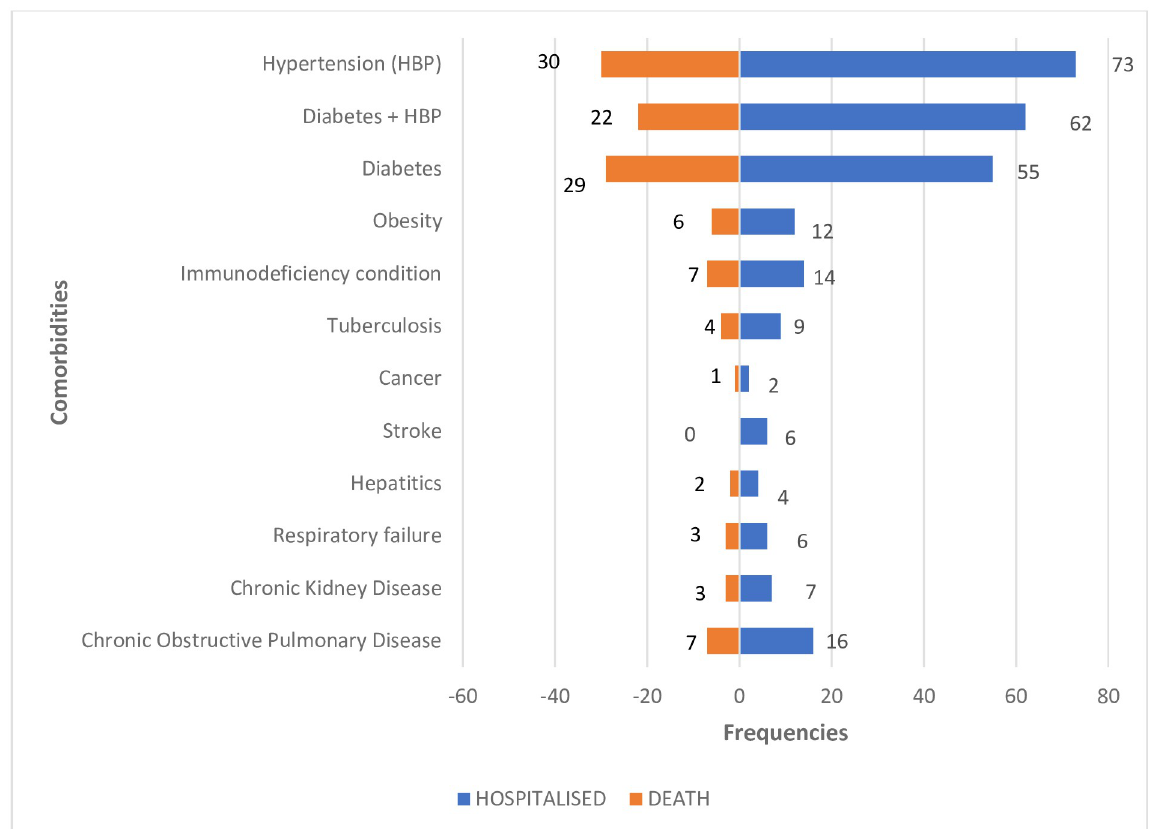
Fig 4. Distribution of COVID-19 confirmed hospitalised cases and deaths according to comorbidities.